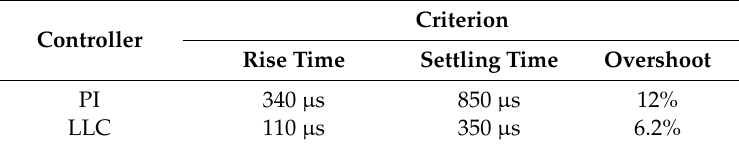
Table 3. LLC robustness against variations in parameters of the boost converter.